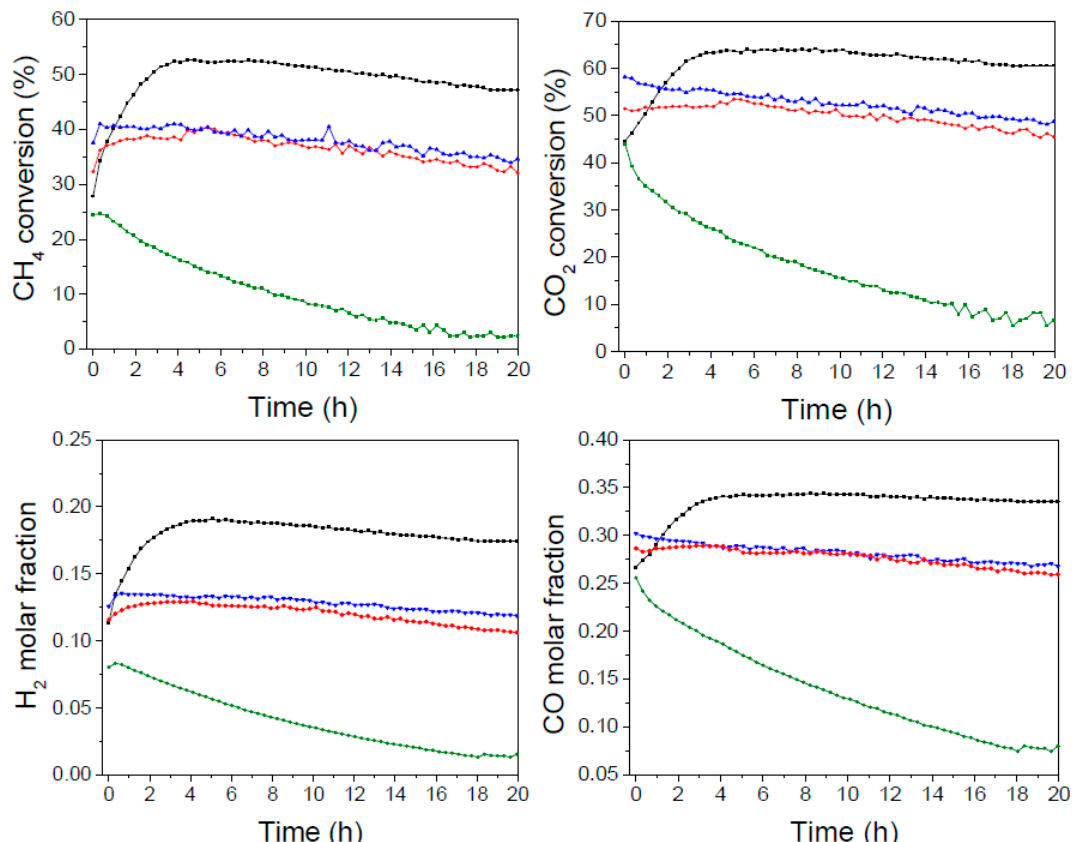
Figure 6. Reactant conversion, products molar fraction and H 2 /CO ratio. La 1-x Ba x NiO 3 (x = 0.0, 0.1, and 0.2) and NiO/La 2 O 3 . Feed: CH 4 /CO 2 /Ar = 25/25/50 mL ∙ min –1 . T = 700 °C, GHSV=200.000 NL ∙ h –1 ∙ kg –1 . (black line) LaNiO 3 ; (blue line) La 0,90 Ba 0,1 NiO 3 ; (red line) La 0,8 Ba 0,2 NiO 3 ; and (green line) NiO/La 2 O 3 .